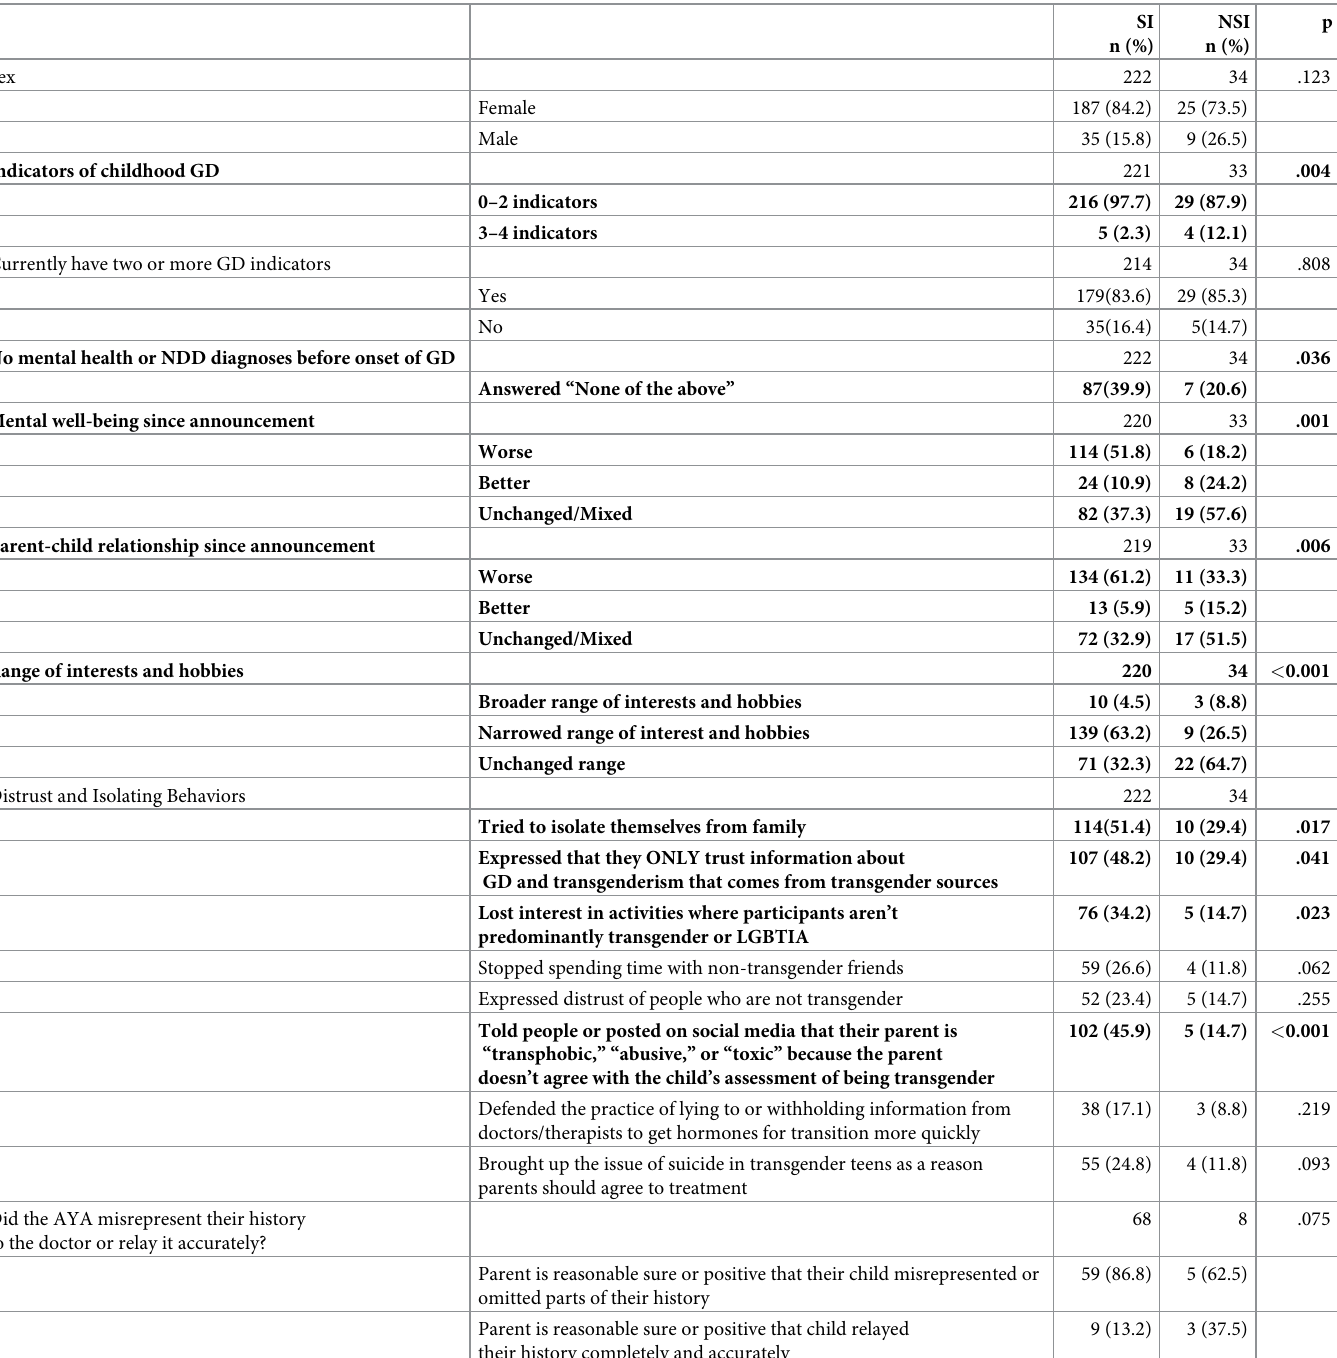
Table 13. chi-squared comparisons for exposure to social influence (SI) vs not exposure to social influence